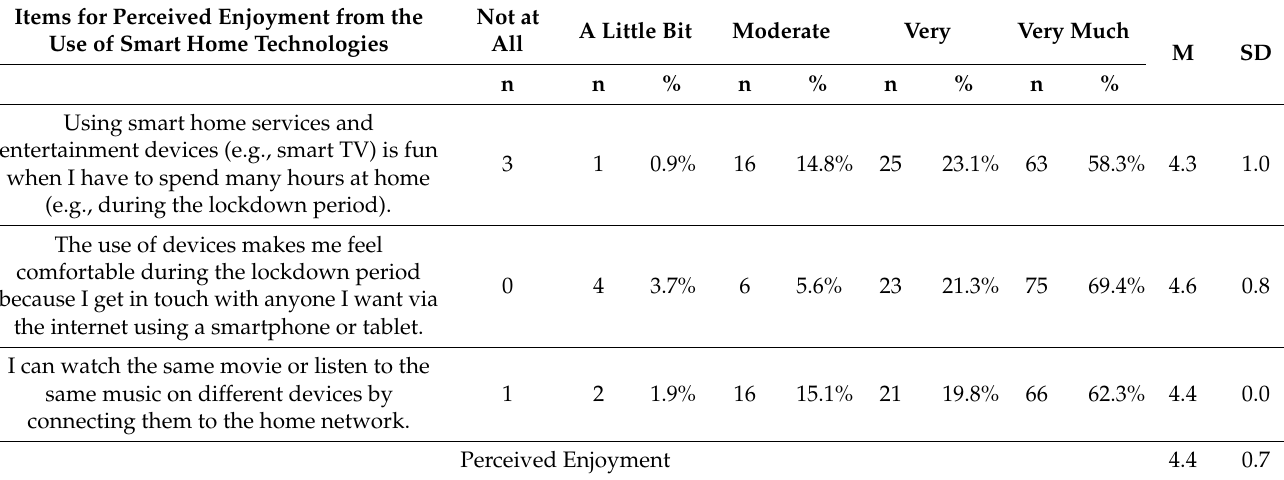
Table A7. Perceived enjoyment from the use of smart home technologies.